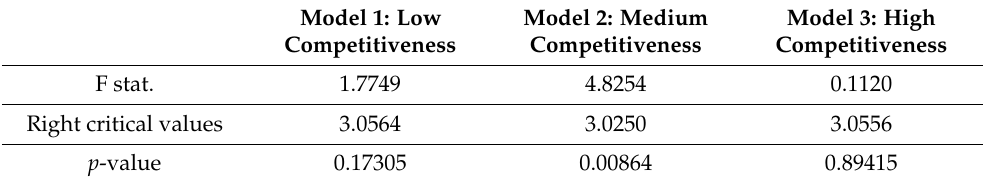
Table 2. The results for RESET